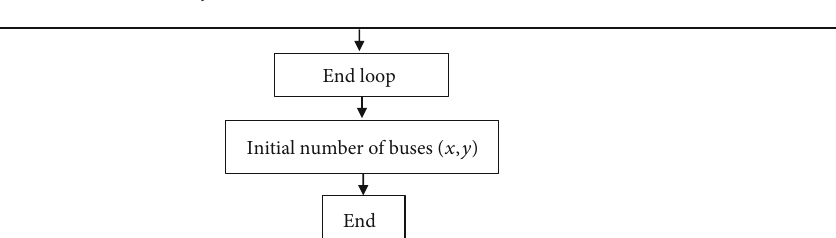
Figure 1: Adapted methodology for calculating the required